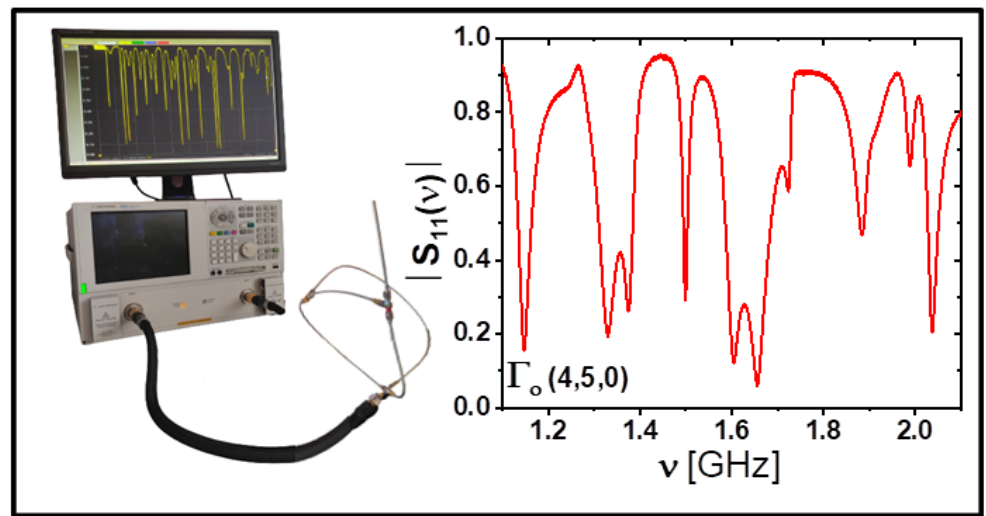
Figure 2. The experimental set-up for measuring the resonances of the microwave networks. It contains an Agilent E8364B vector network analyzer (VNA) and HP 85133-60017 flexible microwave cable that connects the VNA to the measured network. The original microwave network Γ o ( 4,5,0 ) possesses four vertices with the Neumann boundary conditions. In the inset, the measured spectrum of the network Γ o ( 4,5,0 ) is shown in the frequency range ν = [ 1.1,2.1 ]